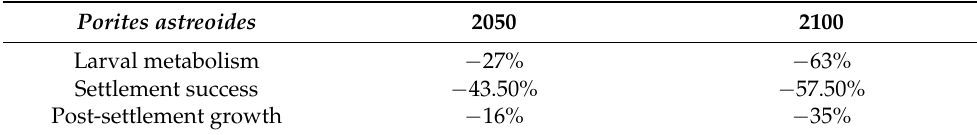
Table 1. Impacts of ocean acidification on P. astreoides under laboratory conditions based on forecasted levels for mid- and late century [90]. Porites astreoides 2050 2100 Larval metabolism − 27% − 63% Settlement success − 43.50% − 57.50% Post-settlement growth − 16% −